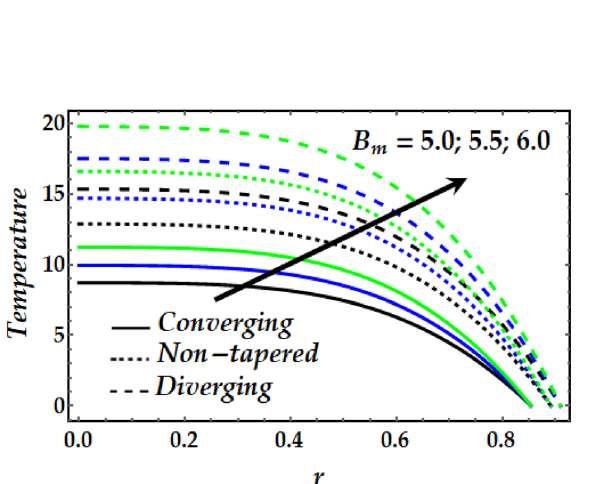
Figure 11. Temperature profile against distinct values of B m